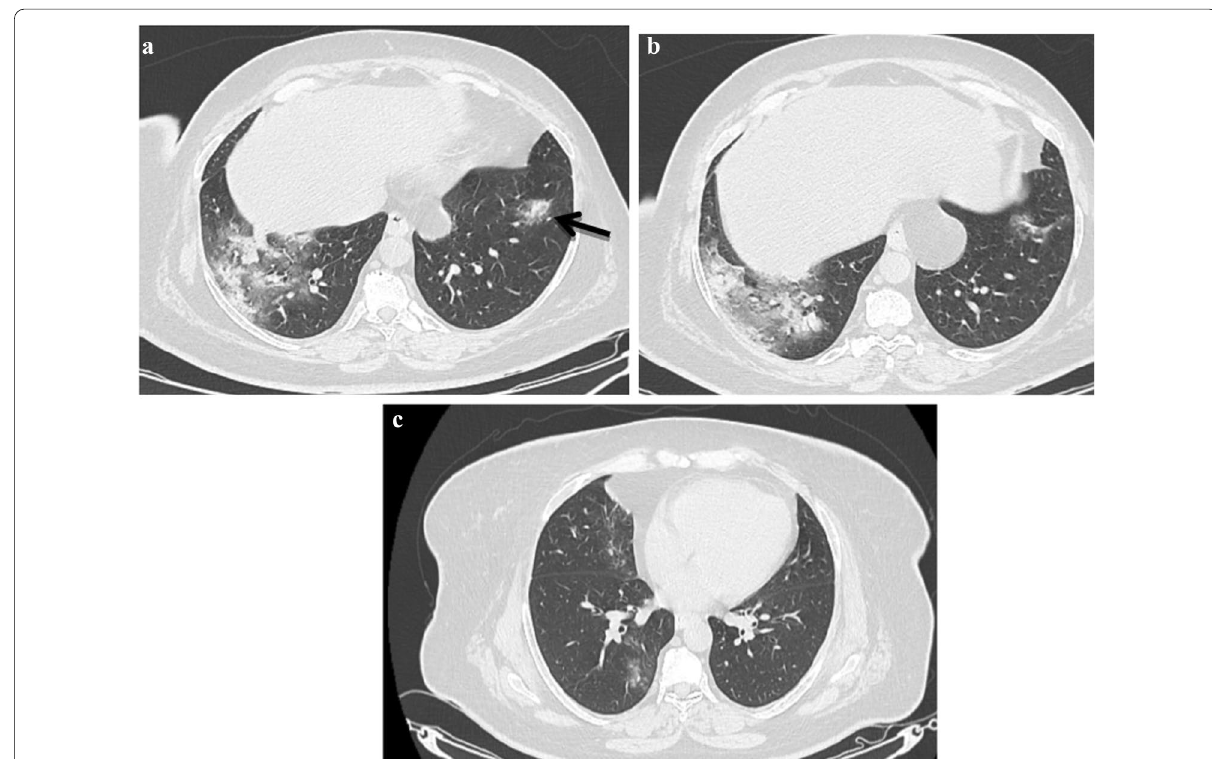
Fig. 2. A 47-year-old female known history of rheumatoid arthritis presented with anosmia, loss of taste, fever, diarrhea and myalgia at May 2020 and positive PCR for COVID 19 infection, a and b noncontrast CT axial cuts shows bilateral patchy subpleural ground glass opacities and consolidations with left lower lobe nodule with ground glass halo sign noted. The patient diagnosed as COVID 19 infection with CT score severity: 16. Second infection dated June 2021 the patient presented with anosmia, loss of taste, fever, diarrhea and myalgia with positive PCR test for COVID 19 infection. c noncontrast CT chest images show bilateral patchy subpleural ground glass opacities. The patient diagnosed as COVID 19 re-infection with CT severity score: